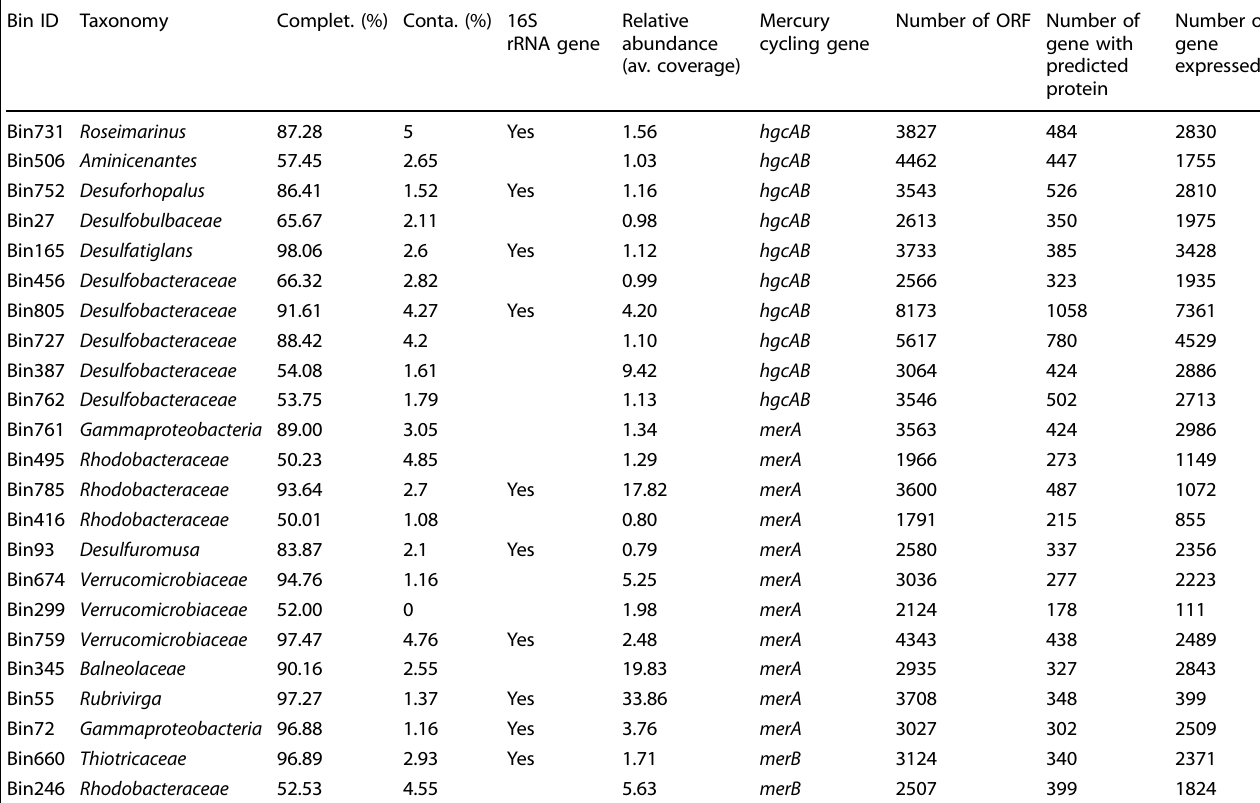
Table 1. Detailed description of the MAGs with mercury transformation genes recovered in the microbial mats. Bin ID